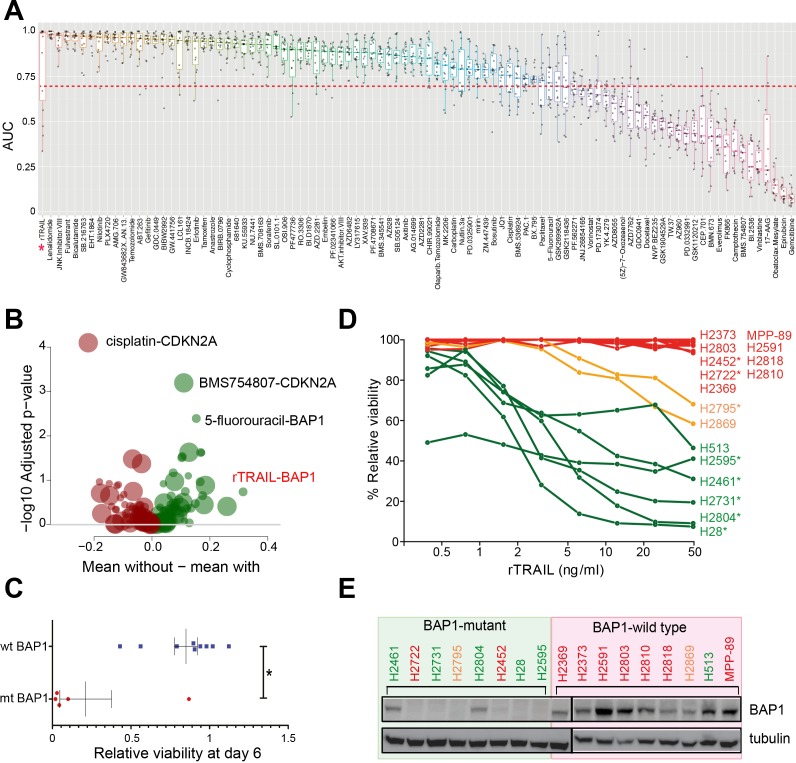
A chemical screen in mesothelioma cell lines identifies a BAP1-mutant population sensitised to the death receptor ligand rTRAIL.(A) Area under the curve (AUC) values for 15 malignant mesothelioma (MM) cells treated for 6 days with 94 compounds. Each dot indicates the AUC value for an individual cell line treated. AUC <0.7 is indicated by the red dotted line — only those compounds with ≥2 cell lines below this value were analysed for statistically significant associations with gene mutations. The AUC values for rTRAIL are indicated by the red asterisk. (B) A Welch t-test was used to test for significant pharmacogenomics interactions between the 94 single agents in the screen and the presence of driver mutations in any of 5 MM cancer genes. Each volcano plot circle corresponds to a significant gene–drug interaction whose position on the x-axis indicates the corresponding effect size. Both half-axes are positive; the right side (green circles) indicates the effect sizes of sensitivity associations, whereas the left side (red circles) corresponds with the effect sizes of resistance associations. The position on the y-axis indicates the statistical significance of the identified interaction. The size of a given circle is proportional to the number of samples in which the selected functional event involved in the corresponding interaction occurs. Specific examples of associations are indicated where the effect size is large (rTRAIL and BAP1 mutations) or highly significant (cisplatin and CDKN2A mutations). (C) Cell viability between wild-type BAP1 (wt BAP1) (n = 10) and mutant BAP1 (mt BAP1) (n = 5) MM lines following 6 days of treatment with rTRAIL (t-test; *p=0.015). (D) Cell viability data for 17 MM lines treated for 6 days with a concentration range of rTRAIL (0.4–50 ng/ml). MM lines are coloured according to their sensitivity pattern (green = sensitive (S); orange = partially sensitive (PS); red = resistant (R)). *Indicates cell lines harbouring BAP1 mutations. (E) Immunoblot of BAP1 protein expression in BAP1-mutant versus BAP1-wild-type MM cell lines. Sensitivity to rTRAIL treatment is indicated as font colour: green (S); orange (PS); red (R).